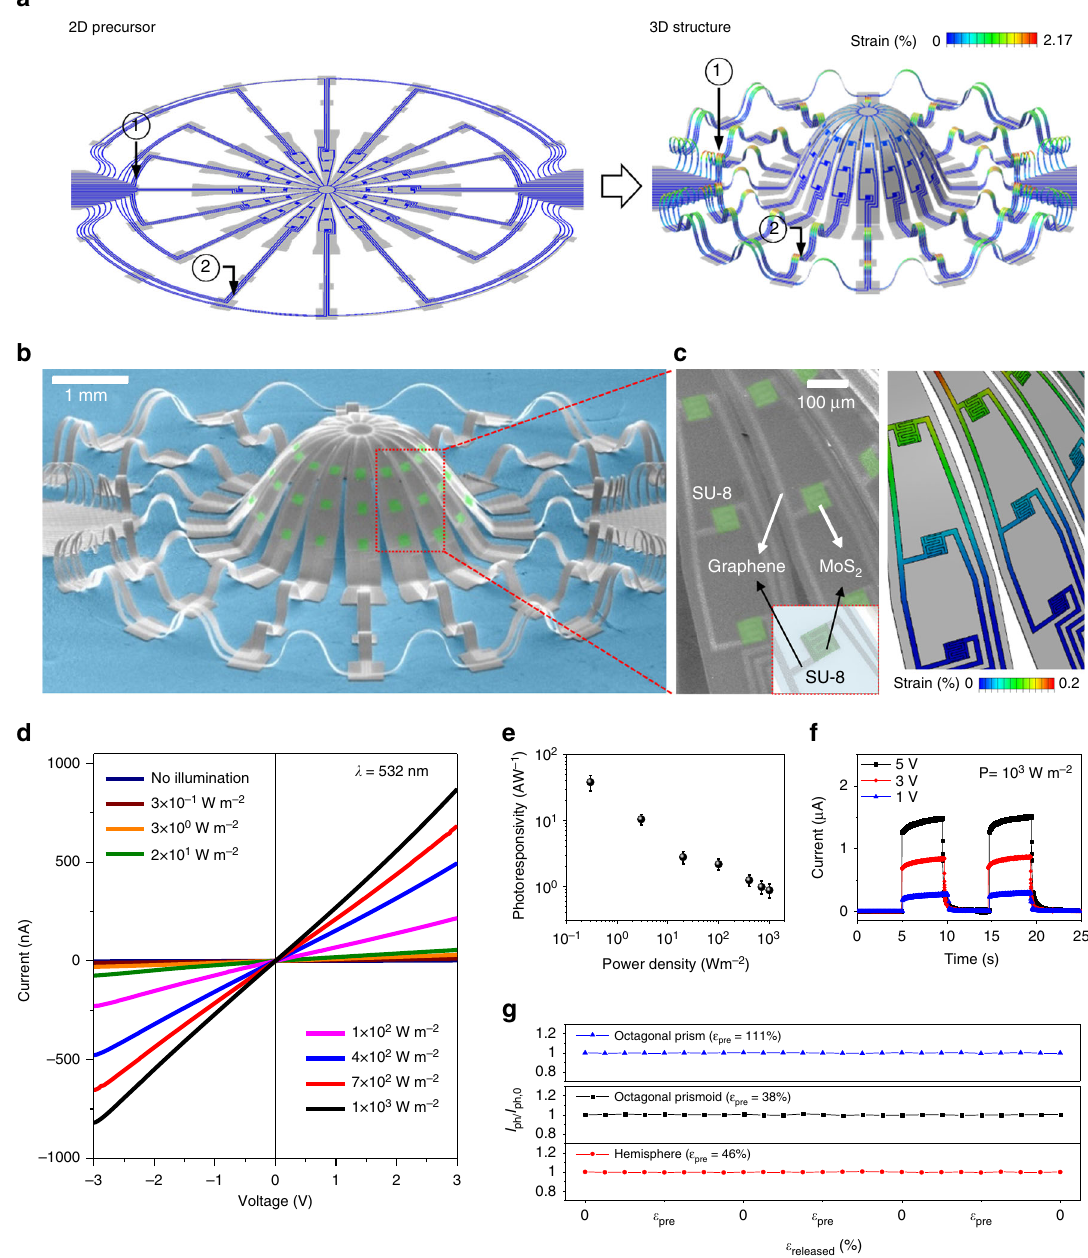
Fig. 2 Interconnect design and photoinduced response of MoS 2 photodetectors on a 3D hemispherical structure. a FEA of the 3D hemisphere structures before and after compressive buckling, showing the distributions of maximum principal strains in the MoS 2 photodetectors and 3D interconnects. b Colorized SEM image of MoS 2 photodetectors consisting of MoS 2 (green), graphene (light gray), and SU-8 (gray) on the hemisphere with 3D interconnects. c Magni fi ed view of the SEM image in b and corresponding FEA results for the strain distribution. Inset: schematic illustration of the unit device enclosed by the red box in the main image. d I – V characteristics of the 3D photodetector at different bias voltages (laser-beam wavelength = 532 nm, power density = 1000 W m − 2 ). e Photoresponsivity of the MoS 2 photodetector at a bias voltage of 3 V for different laser power densities. (Standard deviation of 48 sampling distribution recorded from 48 devices.) f Time-resolved photoresponses of the devices under laser illumination at different power densities. g Variation in photocurrent during repeated buckling processes for the octagonal prism (top), octagonal prismoid (middle), and hemispherical structure